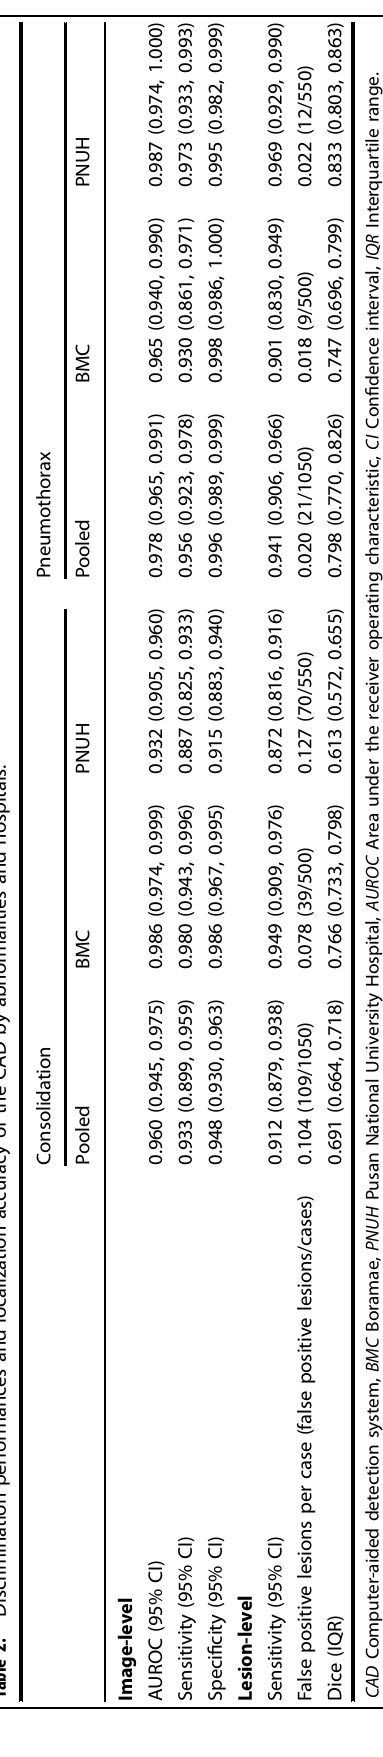
(Table 1). For the consolidation cases, the pneumothorax cases, and the normal cases, the mean age (standard deviation) was